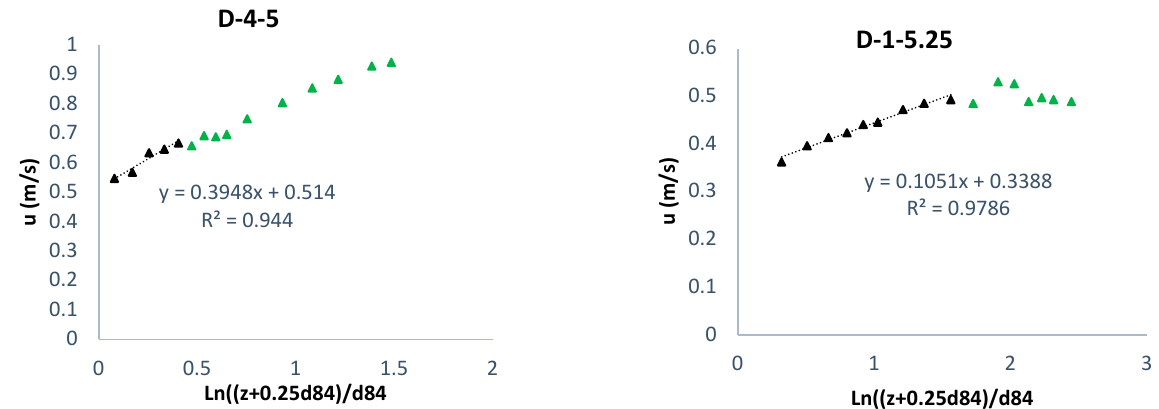
Figure 10. Determining the validity of the logarithmic law in the profiles in the central axis from four selected reaches.